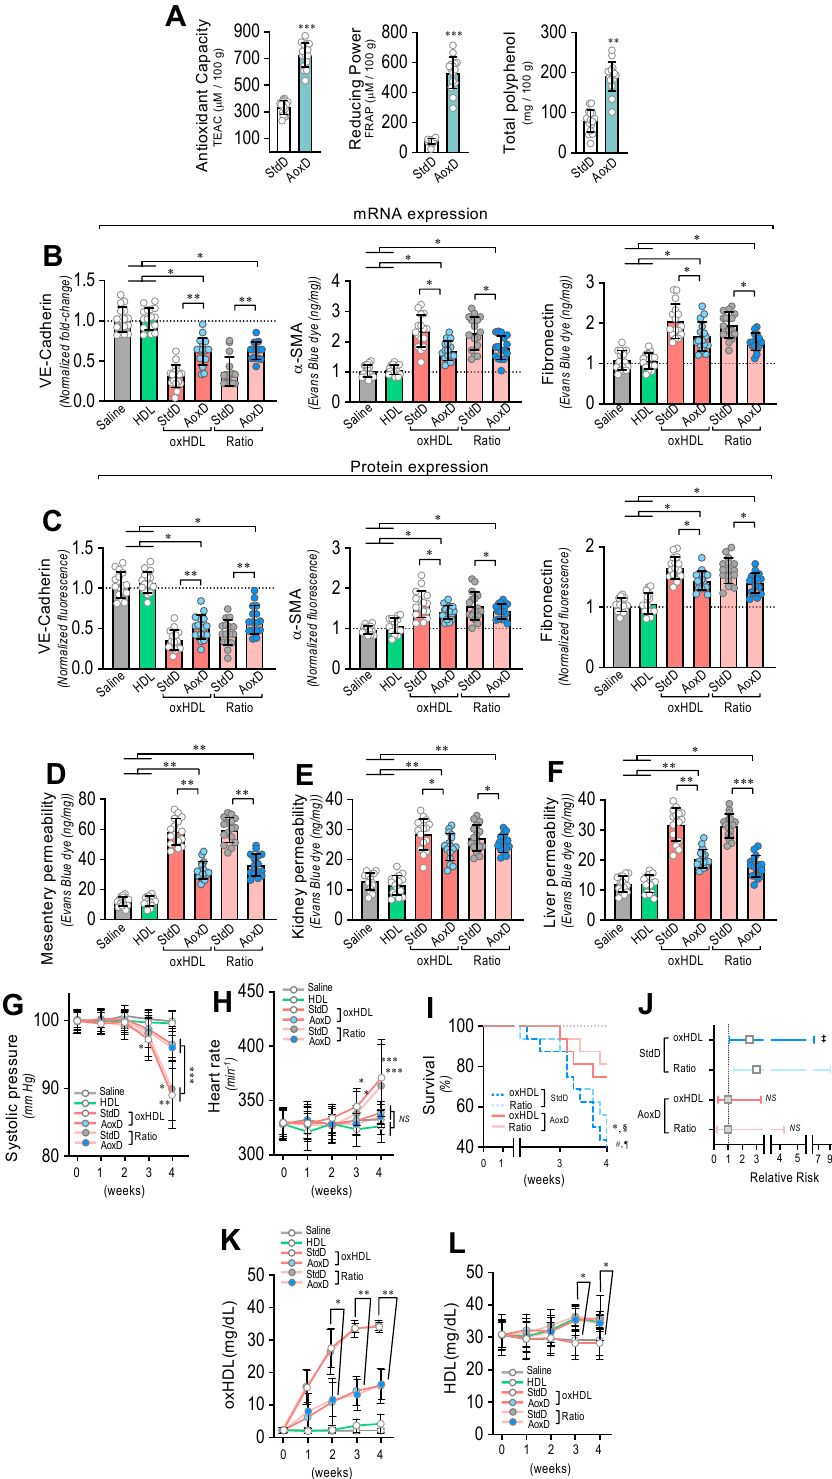
Figure 7. Antioxidant diet consumption inhibits oxHDL-induced endothelial fibrosis and prevents blood vessel hyperpermeability, hypotension, death, and risk of death in rats. ( A ) Antioxidant capacity (left panel), the reducing power (middle panel), and the total polyphenol content (right panel) of antioxidant diet (AoxD) compared to standard diet (StdD). Statistical differences were assessed by Student’s t -test (Mann–Whitney). **, p < 0.01; ***, p < 0.001. Results are expressed as the mean ± SD. ( B , C ). After saline, HDL, oxHDL, and oxHDL/HDL ratio treatments fed with the